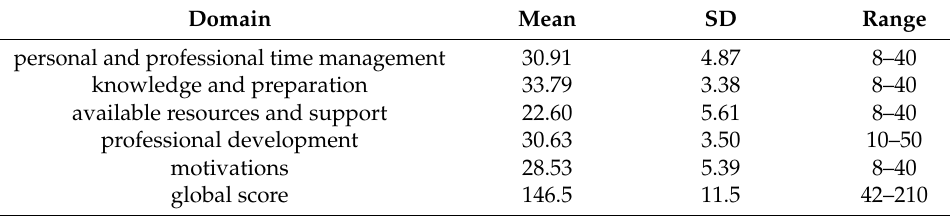
Table 2. Score of the domains and global score of the questionnaire.